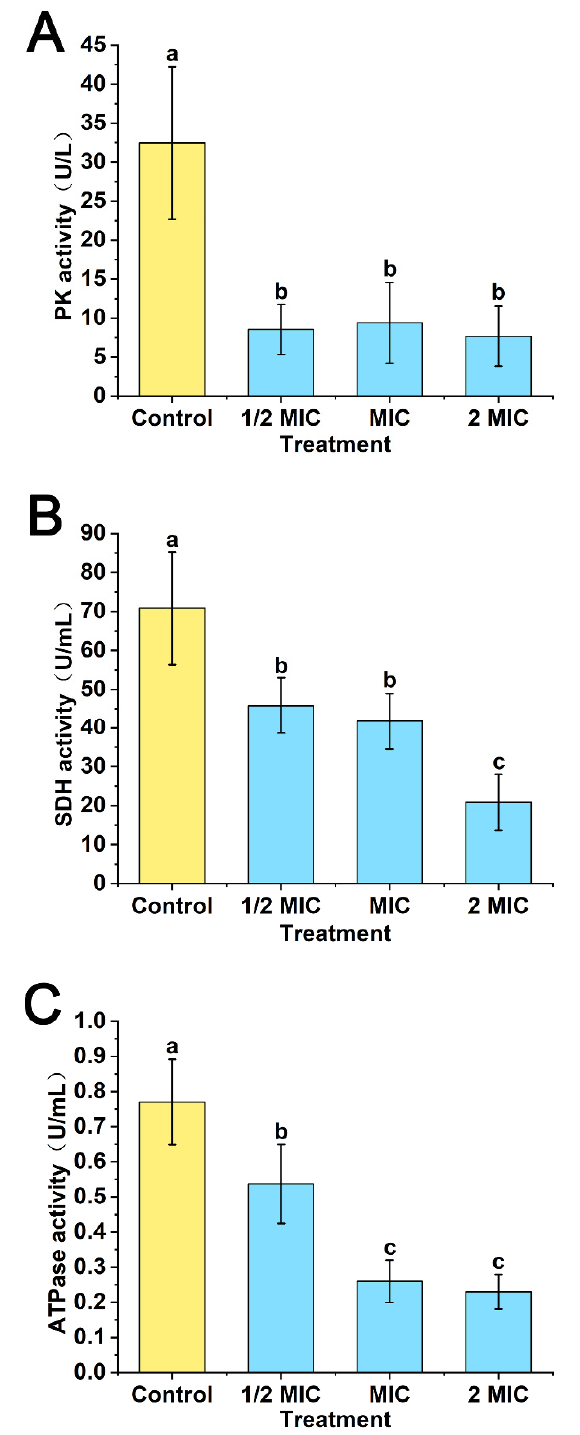
Figure 10. Effects of Polygonum orientale essential oil (concentration: 1/2MIC, MIC, and 2MIC) on pyruvate kinase (PK) activity ( A ), succinic acid dehydrogenase (SDH) activity ( B ) and adenosine triphosphatase (ATPase) activity ( C ). The group treated with DMSO (2%) served as the control. A significant difference was expressed ( p < 0.05).